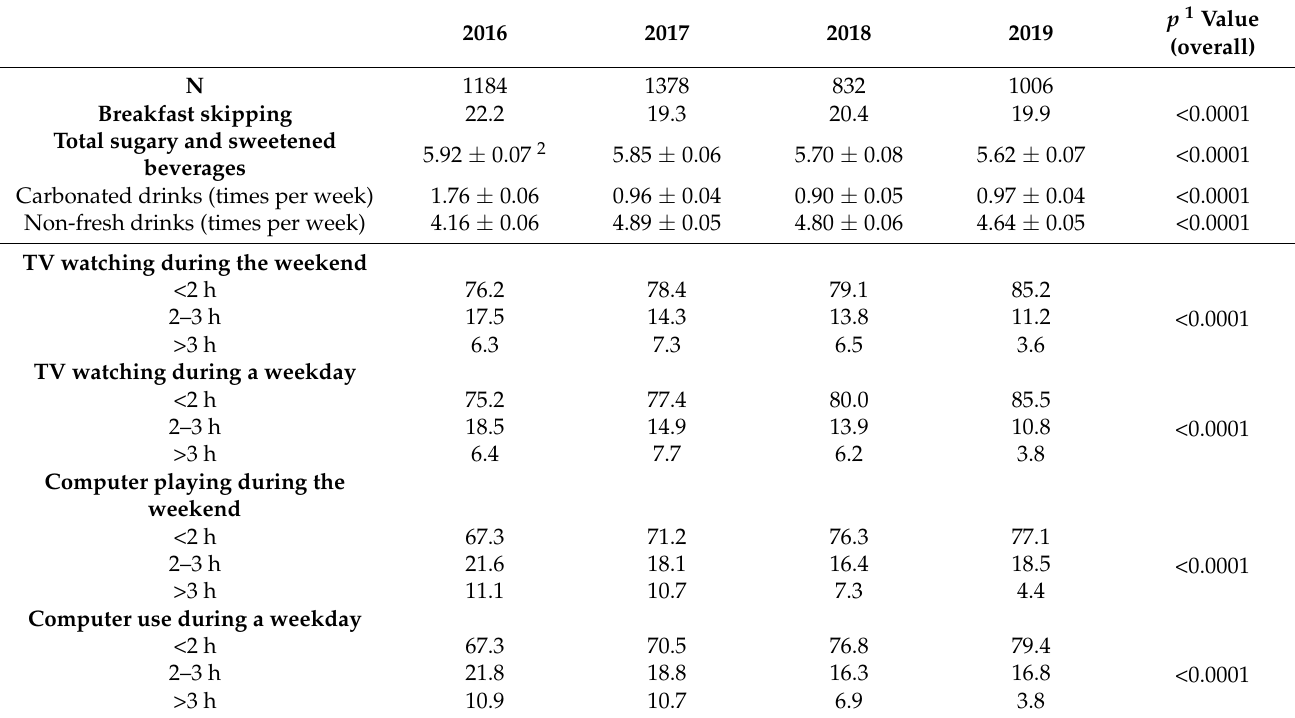
Table 3. By year, distribution of breakfast skipping, sugary and sweetened beverages weekly consumption and daily screen time use.